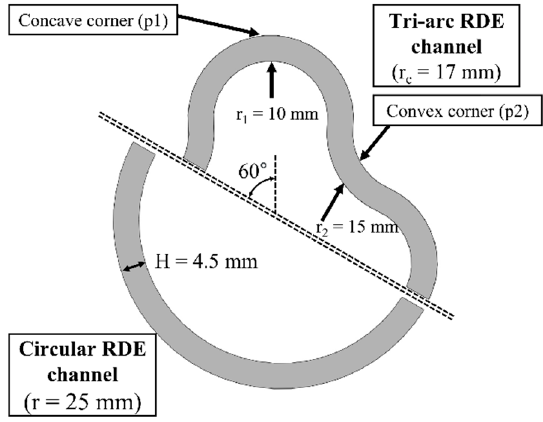
Figure 2. Channel cross-section of circular and tri-arc RDEs.